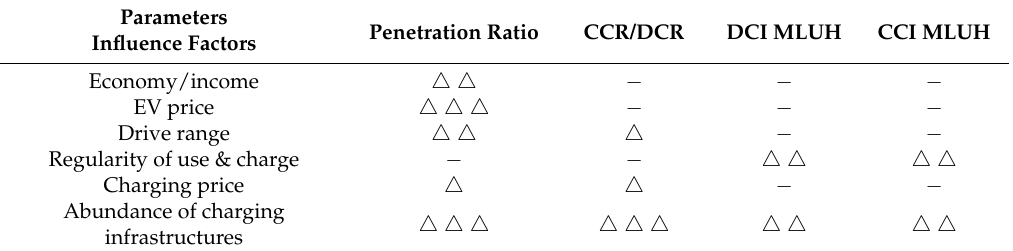
Table 3. The influence factors of each parameter for energy equivalence.